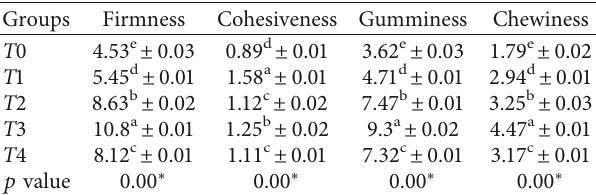
Table 3: Texture analysis of various gluten-free cupcakes and control.